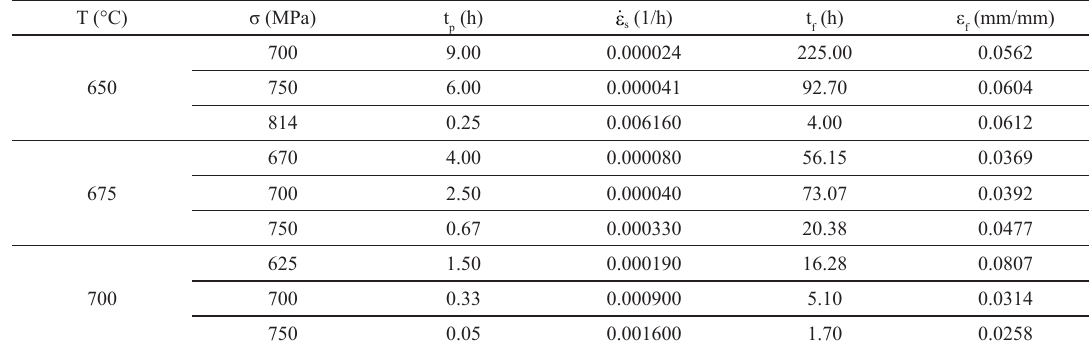
Table 2. Creep test parameters.